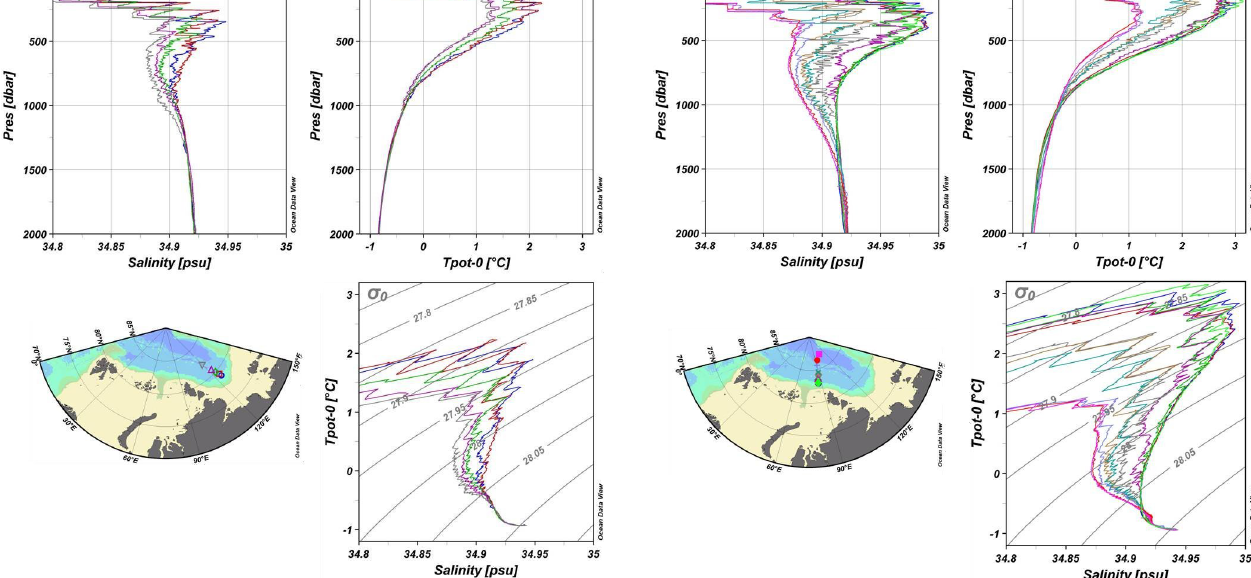
Fig. 13 . Profiles of salinity and potential temperature, and θS curves from the SPACE section 3 from the slope into the Amundsen Basin. The temperature and salinity decrease towards the Amund- sen Basin and two fronts are seen, both located in the Nansen Basin, where also the strongest interleaving is observed. The interleaving layers are here mostly located below the temperature maximum and at and below the salinity maximum. This is different from the situ- ation at the slope (Fig.